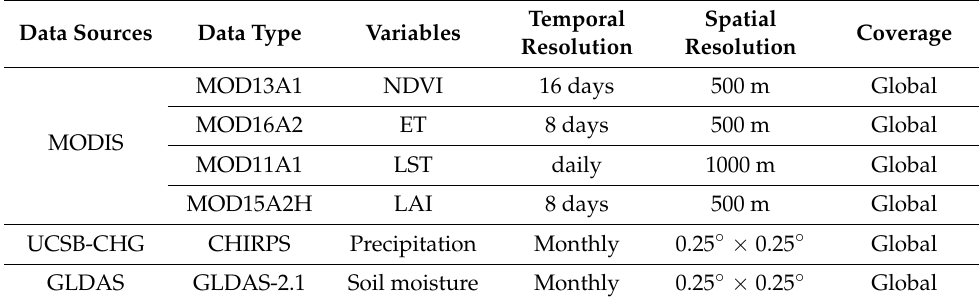
Table 1. Details of the remote sensing datasets used in this study. Data Sources Data